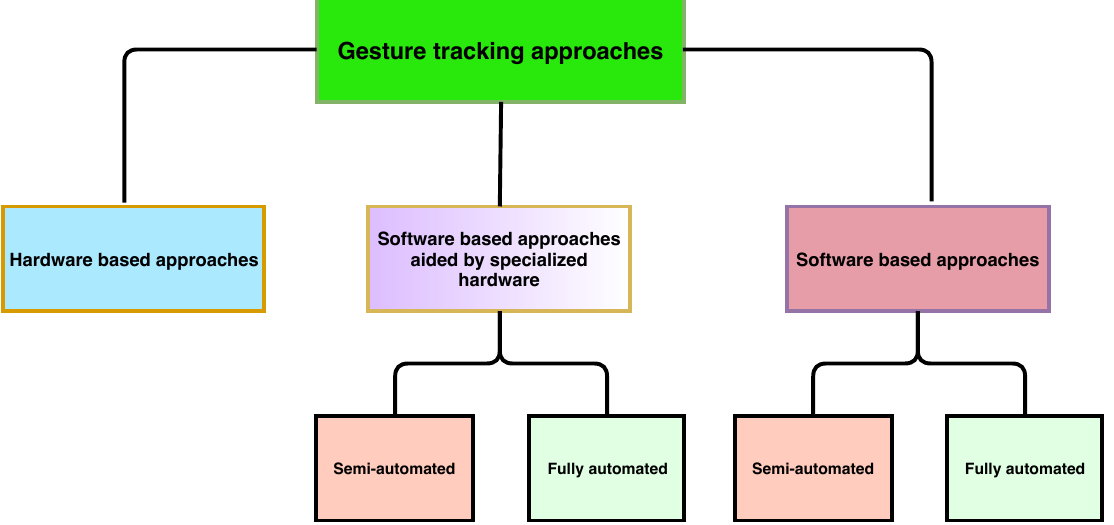
Figure 3. Categories and their hierarchy of the approaches covered in this survey